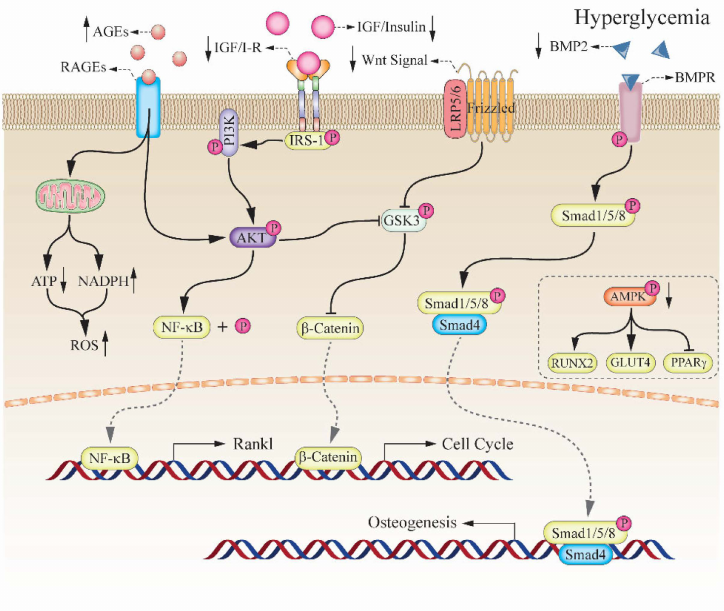
Figure 1. Bone fragility induced by hyperglycemia. High levels of AGEs induced by hyperglycemia resulted in the increase of NADPH and ATP, which lead to high levels of ROS in osteoblastic cells. Insulin deficiency and desensitization of insulin receptors reduced phosphorylation of PI3K through the action of insulin binding its receptor the same as the IGF-1 pathway. Extracellular AGEs binding RAGEs or PI3K stimulate the activation of AKT that thereafter inhibited the phosphorylation of GSK3b that suppresses b-catenin accumulation in the downstream of Wnt signal pathway and dephosphorylates NF-kB that promotes the expression of the RANKL in osteoblast. Furthermore, the downregulation of BMP2 induced by hyperglycemia induces dampened the binding between Smad1/5/8 and Samd4 in the cytoplasm, which blocked that process of osteogenesis. In addition, that the reduced activity of AMPKa under hyperglycemia dismissed the inhibition of PPARg and decreased the expression of RUNX2 and GLUT4, which affected the differentiation of the MSCs into osteoblasts. Refs.